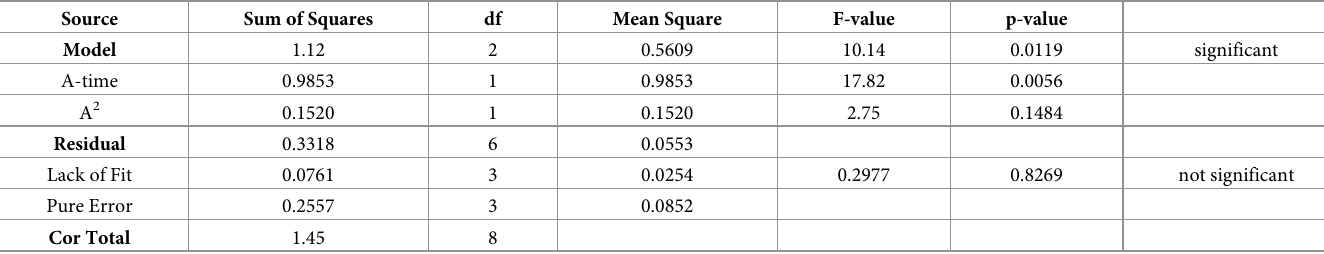
Table 5. ANOVA results of the variable effects on the response stability of immunomagnetic adsorbent (immunomagnetic